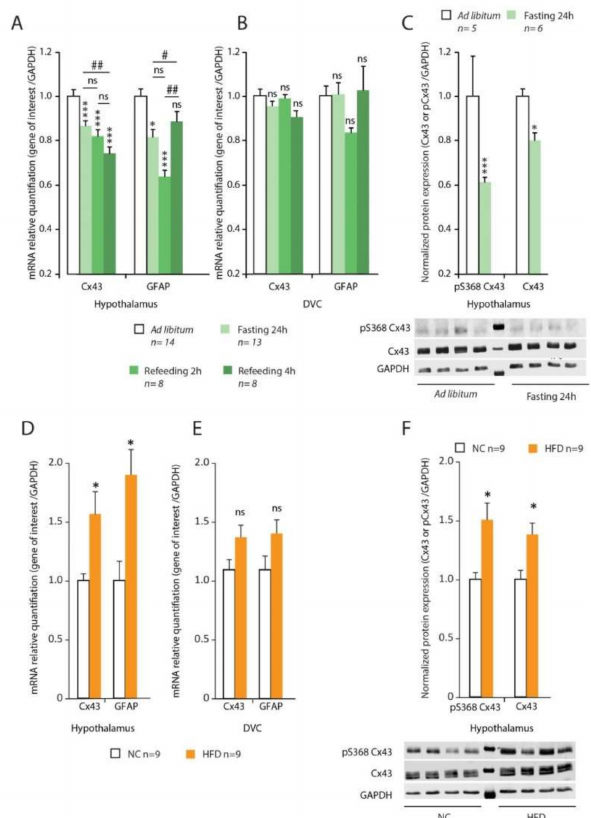
Figure 2. ( A , B ): Connexin-43 (Cx43) and Glial Fibrillary Acidic Protein (GFAP) mRNA expression (normalized with Glyceraldehyde-3-phosphate dehydrogenase gene, GAPDH) was assessed by reverse transcriptase quantitative polymerase chain reaction (RT-qPCR) from the hypothalamus ( A ) and dorsal vagal complex (DVC) ( B ) of control ad libitum ( n = 14), 24 h fasted ( n = 13), 24 h fasted plus 2 h refeed ( n = 8) or plus 4 h refeed ( n = 8) mice. ( C ): Representative Western blot analysis of phosphorylated Cx43 (pS368) and Cx43 expression in the hypothalamus of control ad libitum ( n = 5) and 24 h fasted ( n = 5) mice. ( D , E ): Cx43 and GFAP mRNA expressions (normalized with GAPDH) were assessed by Reverse Transcription quantitative Polymerase Chain Reaction (RT-qPCR) from the hypothalamus ( D ) and dorsal vagal complex (DVC) ( D ) of Normal Chow (NC) ( n = 9) and High Fat Diet (HFD) fed ( n = 9) mice. ( F ): Representative Western blot analysis and quantification of phosphorylated Cx43 (pS368) and Cx43 expression in the hypothalamus of NC ( n = 9) and HFD-fed ( n = 9) mice. A two-way analysis of variance test was performed between di ff erent experimental groups * p < 0.05 and *** p < 0.001 significantly di ff erent from control ad libitum. # p < 0.05 and ## p < 0.001 significantly di ff erent from 24 h fasted mice. ns: no significant di ff